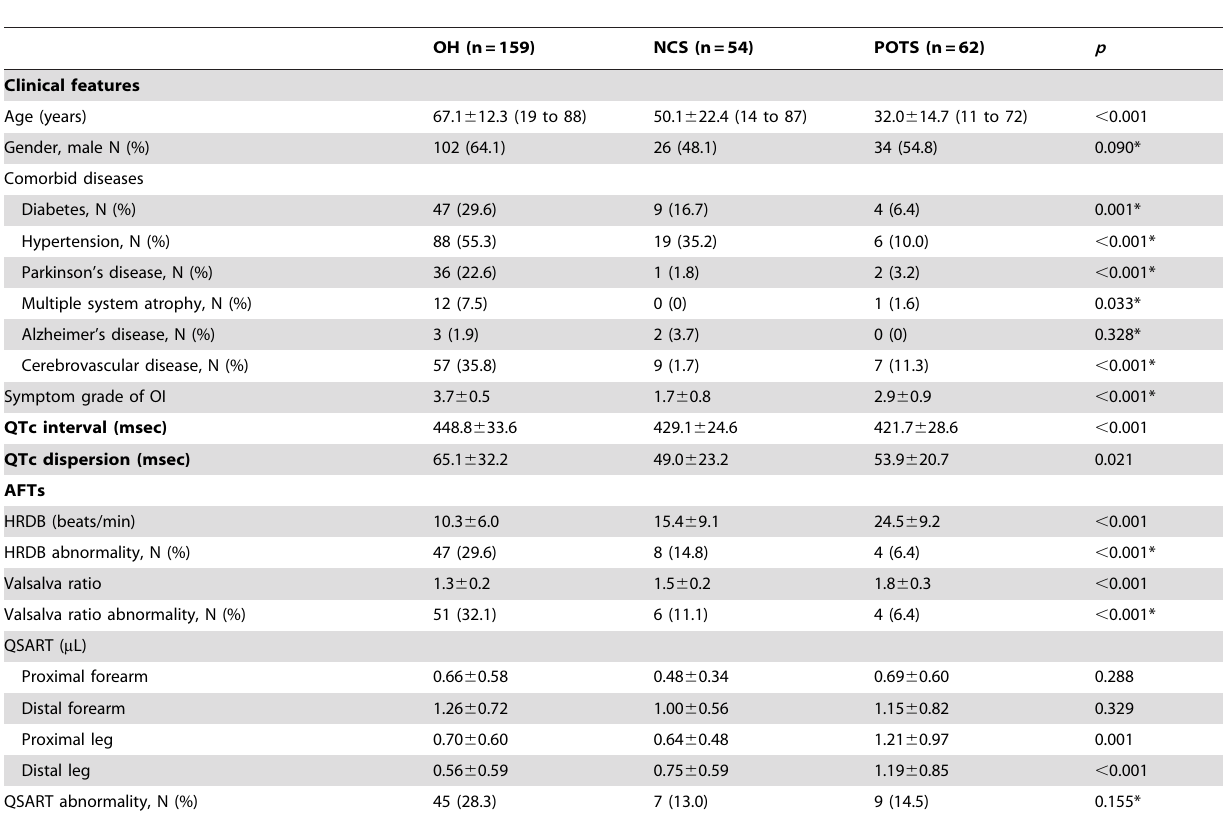
Table 1. Demographic data and clinical measurements in patients with orthostatic intolerance.